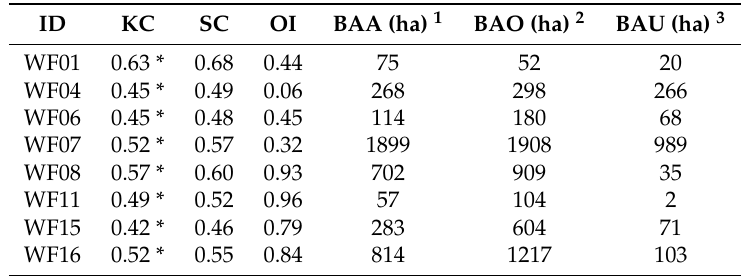
Table 4. Statistical evaluation of IRIS’ wildfire spread forecasts during the 2019 fire season in Greece. Values of KC followed by * denote statistical significance (Z-test) at p ≤